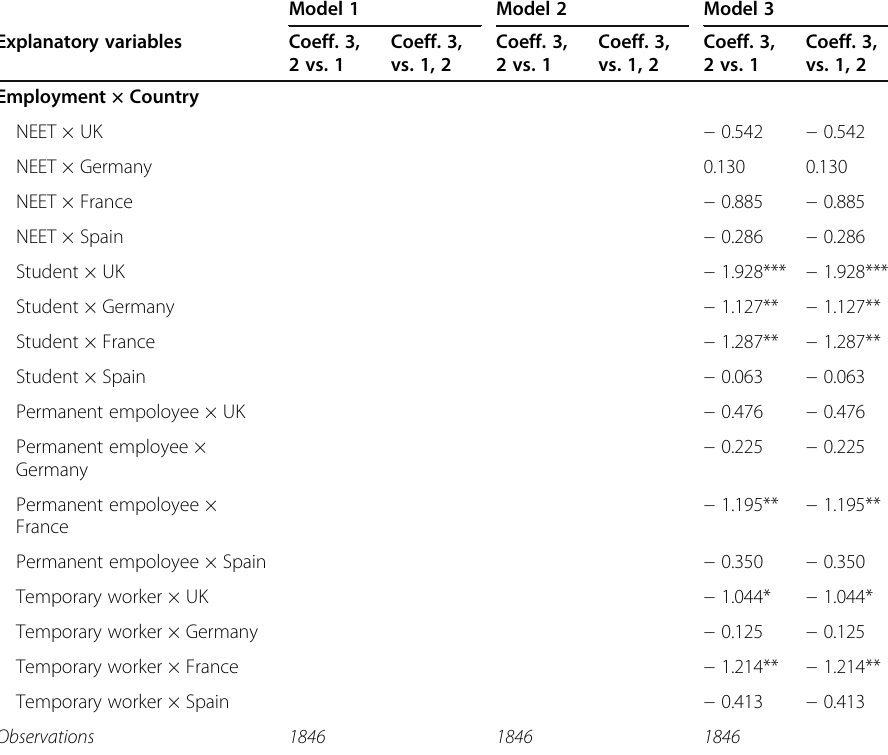
Table 4 Results of generalized ordered logistic regression for the determinants of the decision of postponing or abandoning the plan of going to live on their own